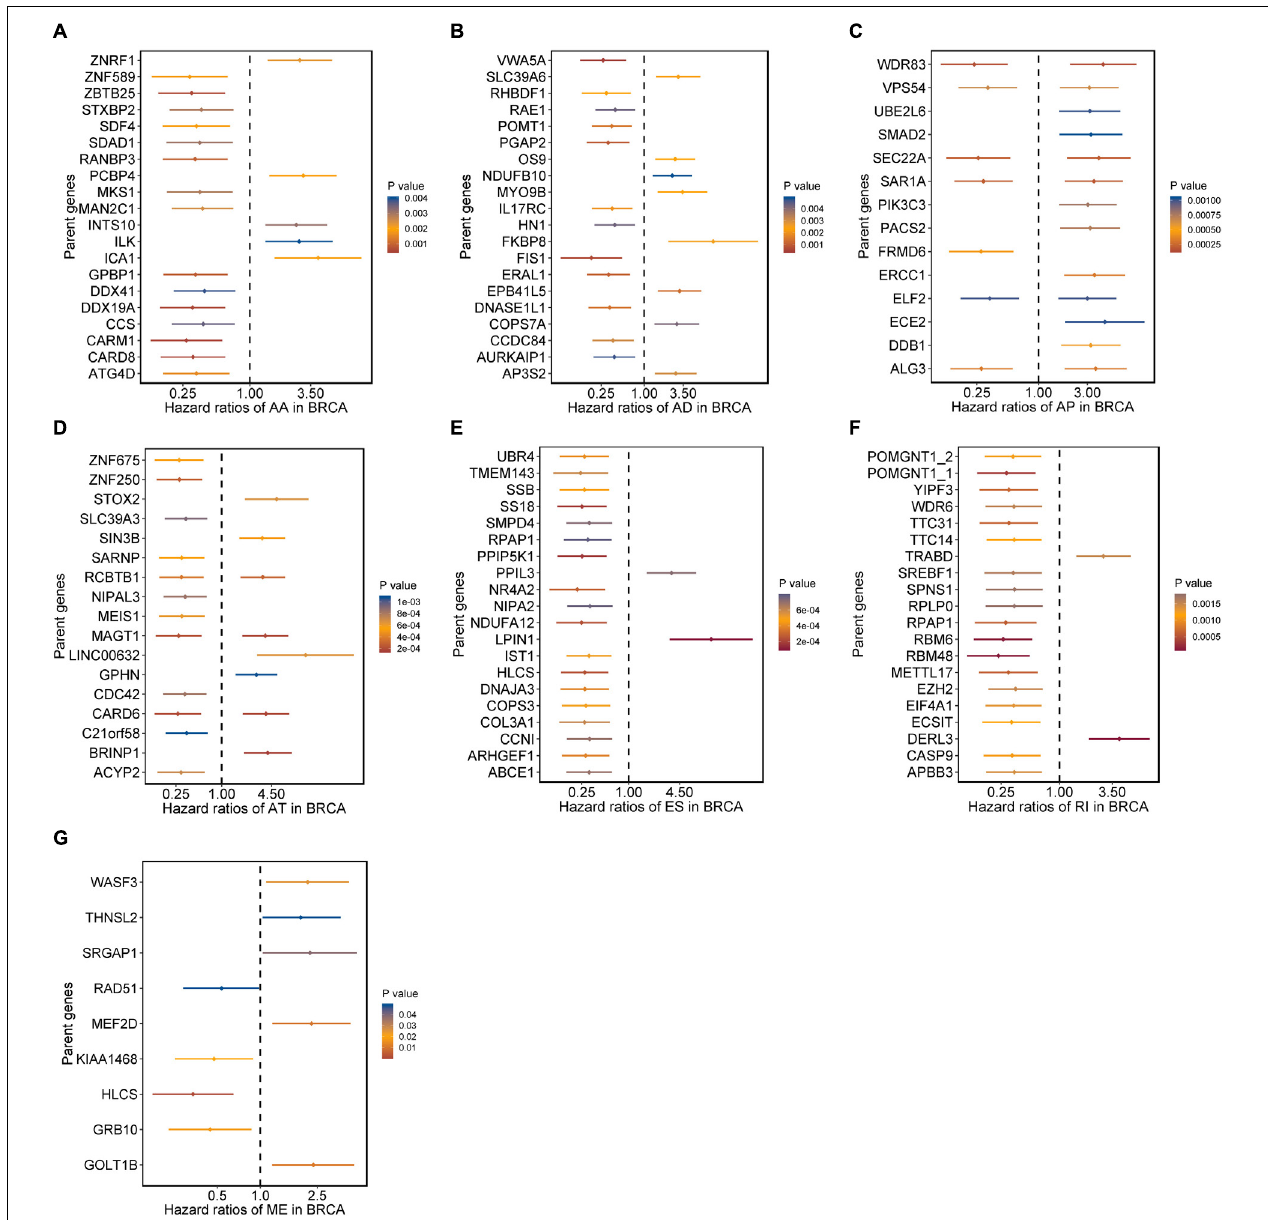
FIGURE 2 | Forrest plots of survival associated AS events in BRCA. (A–F) Hazard ratios and 95% confidence intervals of top 20 overall survival associated AA, AD, AP, AT, ES, and RI events, respectively. (G) Hazard ratios and 95% confidence intervals of significant OS associated ME events. P -values of univariate Cox analyses are indicated by color scale by the